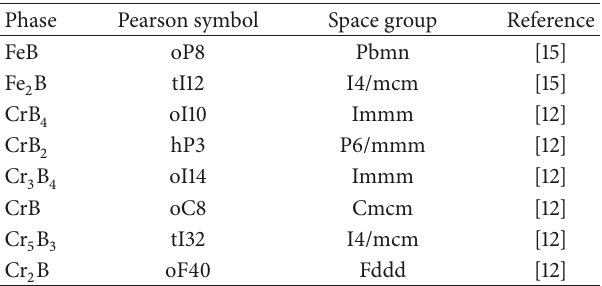
Table 2: Crystal structure data of borides.